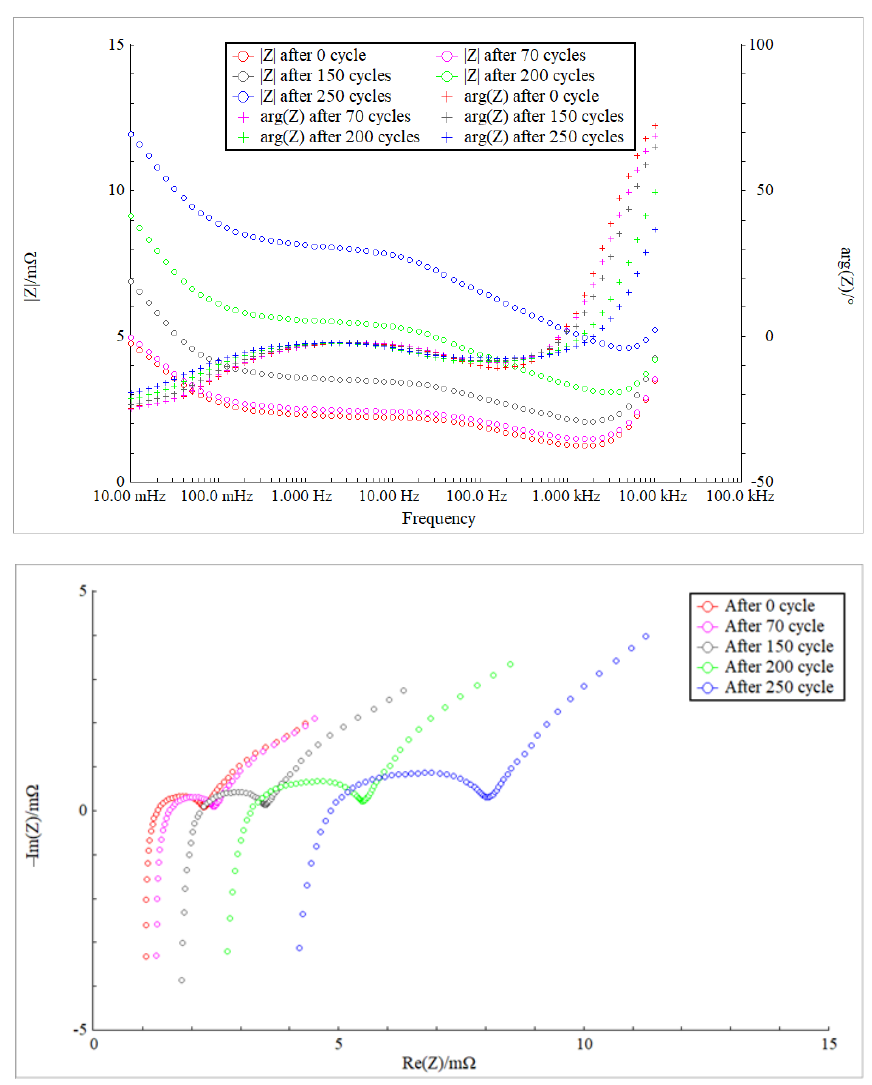
Figure 4. Bode curve and Nyquist curve of the battery after different numbers of cycles (15 C).